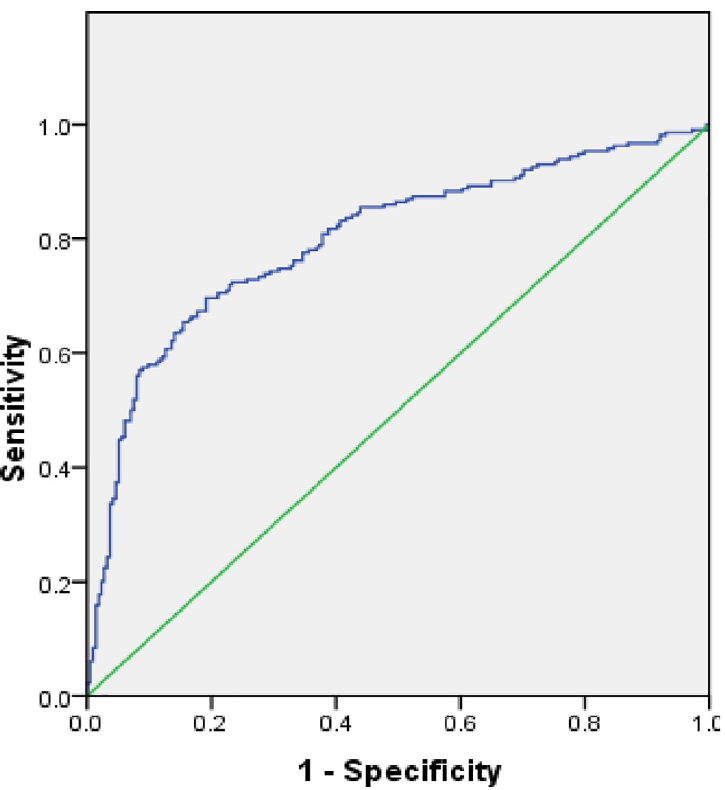
Fig 12. Receiver operator characteristic (ROC) curve based on data from March 29, 2020.